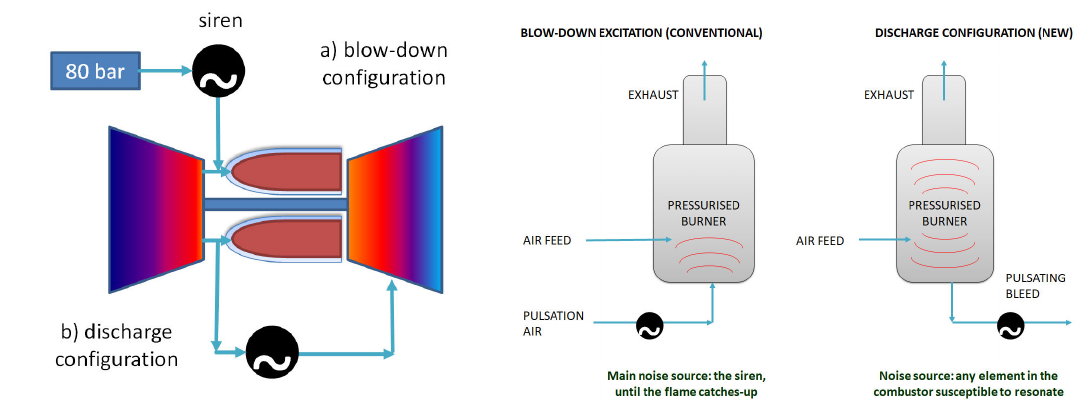
Figure 11. Possible implementations of a siren on a gas turbine for flow control [3,9]: ( left ) (a) blow-down and (b) discharge configurations and ( right ) adaption of the siren configurations on the pressurised test